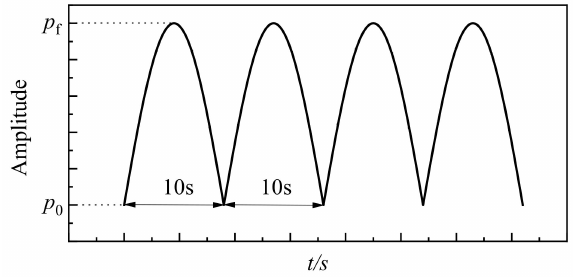
Figure 4. Schematic diagram of loading